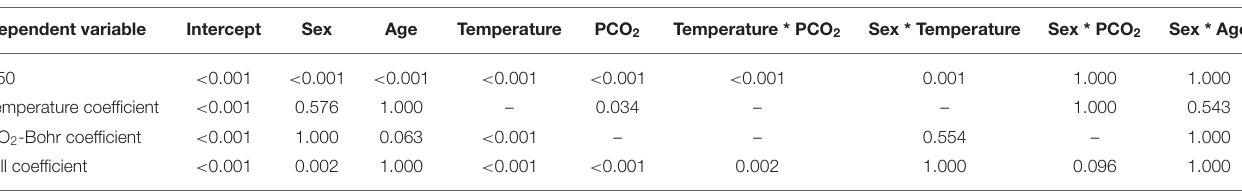
TABLE 2 | p -Values of the factors inserted in the